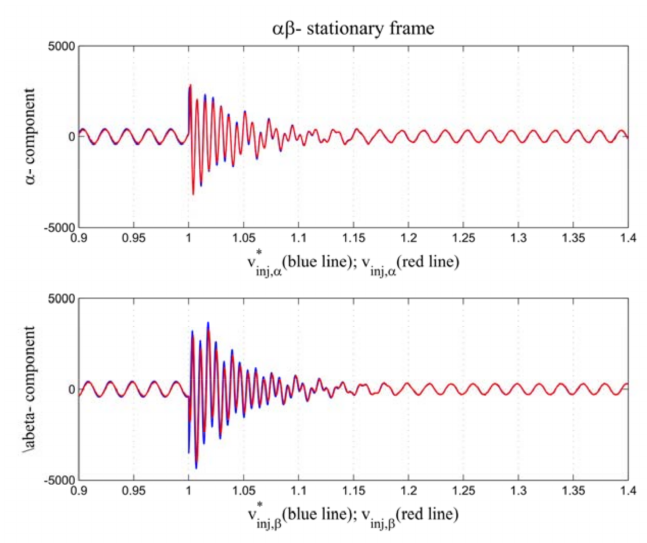
Figure 19. Case 6-Comparison of the difference between v ∗ fluctuations and distortions